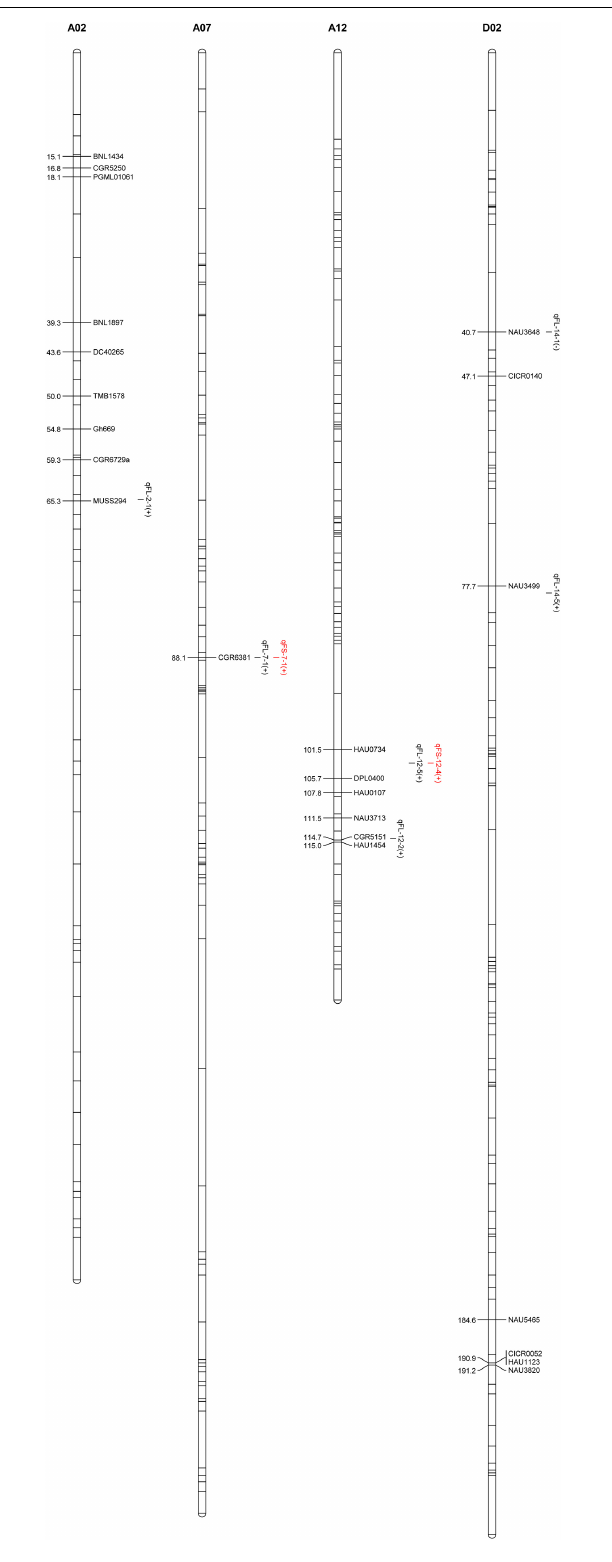
FIGURE 2 | The chromosomal distribution of QTLs associated with FL and